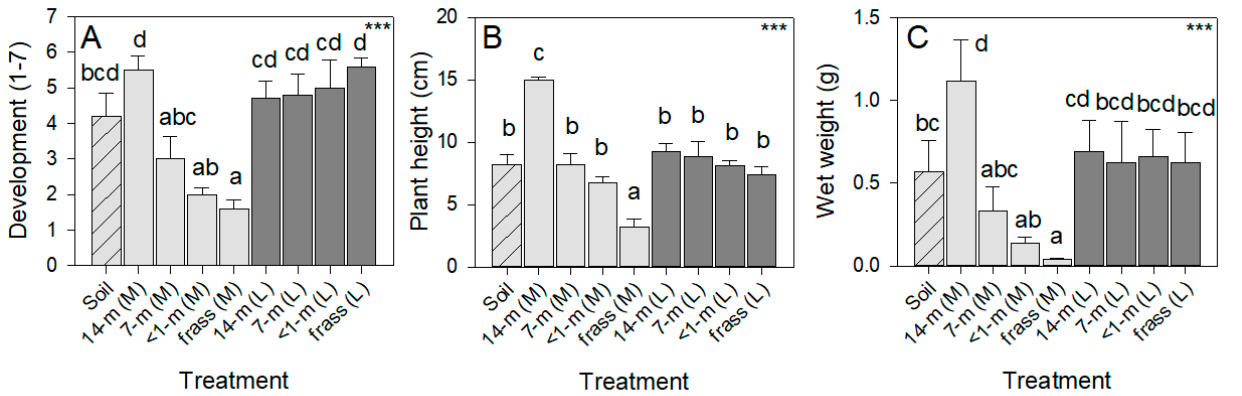
Figure 4. Growth of tomato seedlings in soil with SCG amendments. Results for plant development ( A ), plant height ( B ) and wet weight ( C ) are presented for plants grown in unamended soil (hatched bars) and soil with SCG amendments (solid bars). Amendments included 14-, 7- and <1-month-old SCG, as well as frass from BSF larvae reared on SCG. Each amendment was applied either mixed with the soil (M = light gray bars) or as a layer on top of the soil (L = dark gray bars). Results of GLMs are indicated as *** = p < 0.001. Lowercase letters indicate homogenous substrate groups (Tukey p > 0.05). Standard errors are indicated (N = 5).